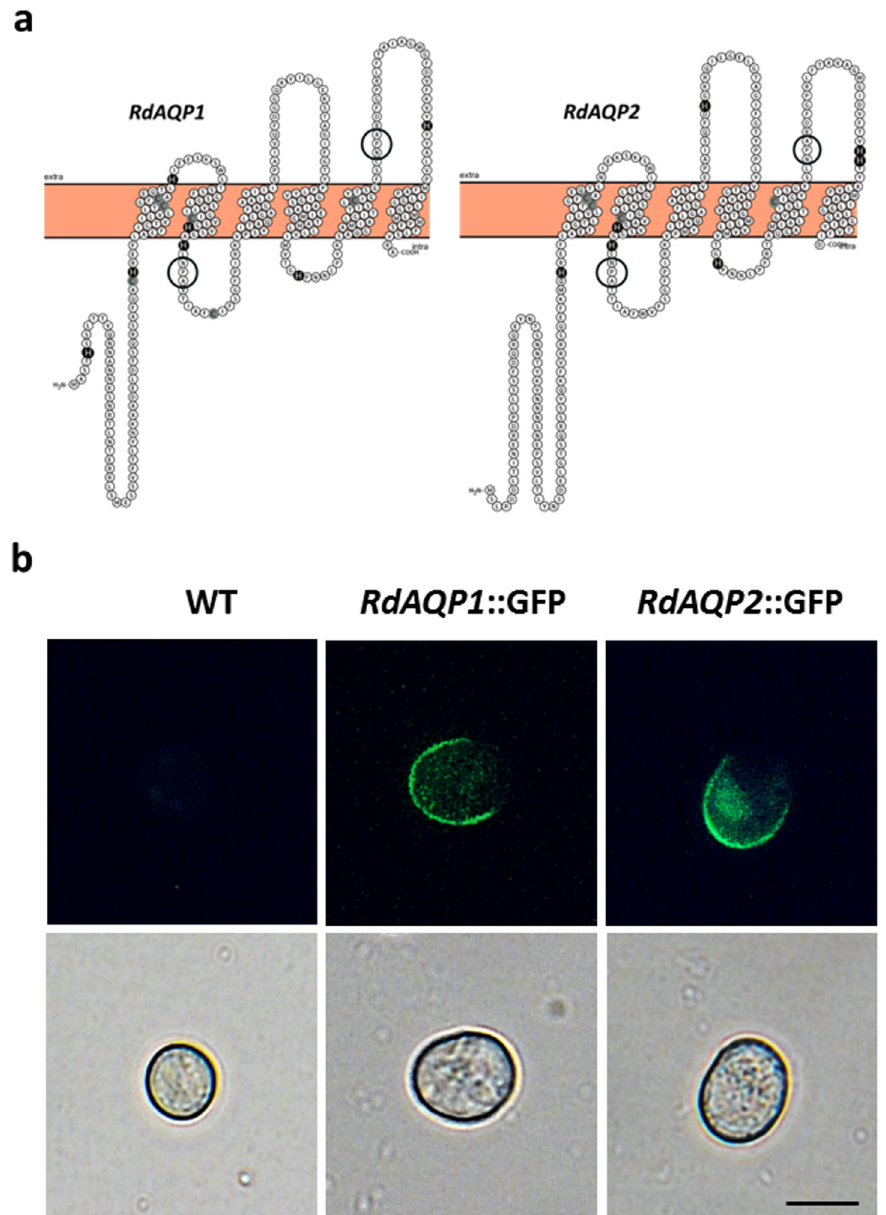
Fig 5. Predicted topology and localization of RdAQP1 and RdAQP2 proteins. (a) Hypothetical prediction of RdAQP1 and RdAQP2 topology by the TMHMM method, drawn by the Protter-visualize proteoforms program [53], showing the proteins' six transmembrane domains. The highly conserved NPA domains are circled. The Cys and His amino acids are filled in gray and black color, respectively. (b) Expression of RdAQP1::GFP and RdAQP2::GFP in R . delemar spores. Bar = 10 μ